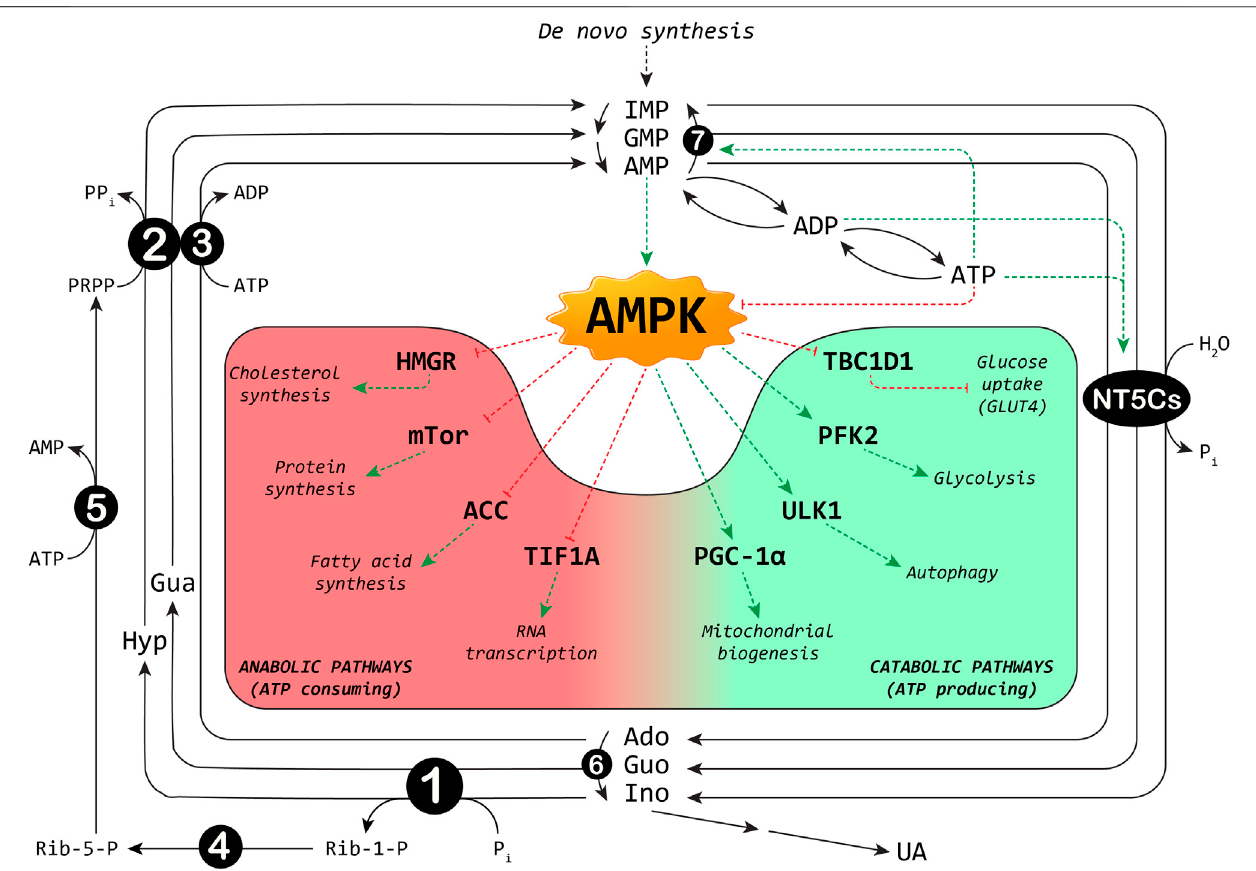
FIGURE1| InterplaybetweenpurinecyclesandAMPK.AselectionofmetabolicpathwaysregulatedbyAMPKisshown:theredbackgroundincludestheanabolic pathways switched off, and the green background the catabolic pathways switched on by AMPK. ACC: acetyl-CoA carboxylase; Ado: adenosine; ADP: adenosine-5 ′ - diphosphate; AMP: adenosine-5 ′ -monophosphate; ATP: adenosine-5 ′ -triphosphate; Gua: guanine; Guo: guanosine; GMP: guanosine-5 ′ -monophosphate; HMGR: 3- hydroxy-3-methylglutaryl-Coenzyme A reductase; Hyp: hypoxanthine; IMP: inosine-5 ′ -monophosphate; Ino: inosine; NT5Cs: cytosolic 5 ′ -nucleotidase I and II; mTOR: mammalian target of rapamycin; PFK2: 6-phosphofructo-2-kinase; Pi: inorganic phosphate; PGC-1 α : peroxisome proliferator-activated receptor-gamma coactivator- 1alpha ;PPi:inorganicpyrophosphate;PRPP:phosphoribosylpyrophosphate;Rib-1-P:ribose-1-phosphate;Rib-5-P:ribose-5-phosphate;TBC1D1:TBC1 domain family member one; TIF1A:transcriptionintermediary factor-1 α ;UA: uric acid; ULK1: Unc-51 likeautophagyactivating kinase 1.Enzymesinvolved areindicated by numbers inside circles: 1) Purine nucleoside phosphorylase; 2) Hypoxanthine-guanine phosphoribosyltransferase; 3) Adenosine kinase; 4) Phosphoribomutase;